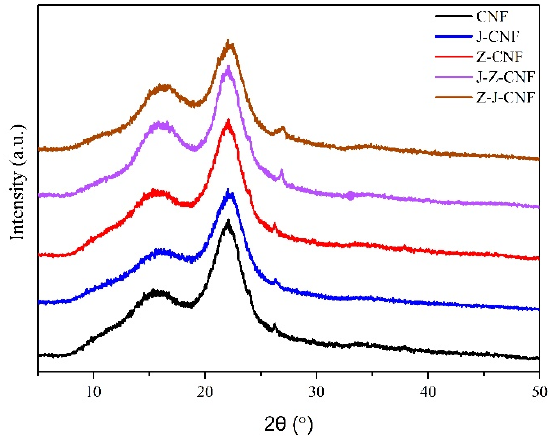
Figure 5. X-ray diffraction (XRD) patterns of CNF and modified CNF. Figure 5. X-ray di ff raction (XRD) patterns of CNF and modified